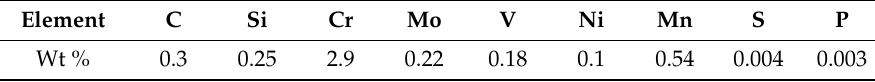
Table 1. Chemical composition of the base metal.